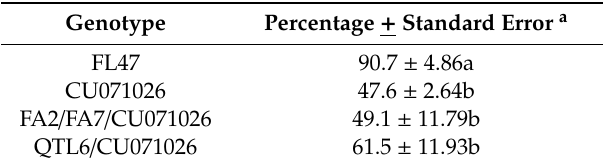
Table 2. Whiteflies’ survival from egg to late instar immatures.